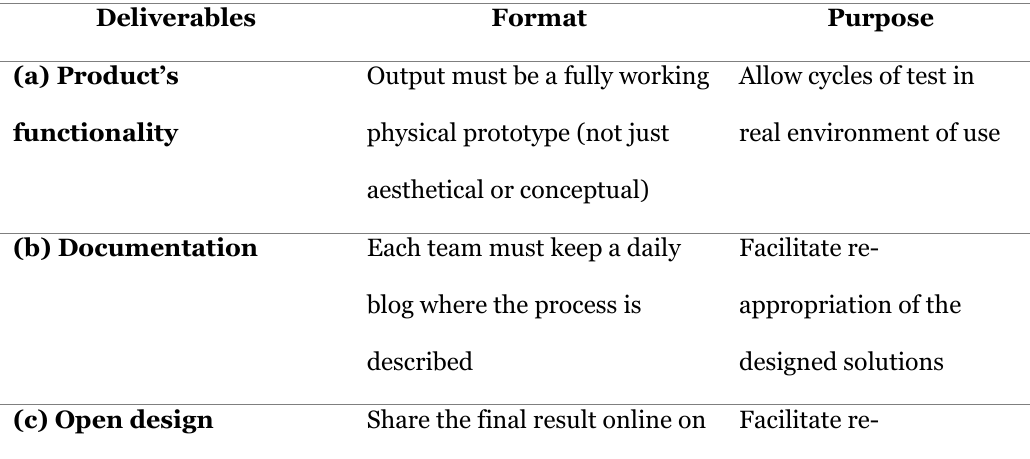
Required Deliverables of the Design Process and Solutions